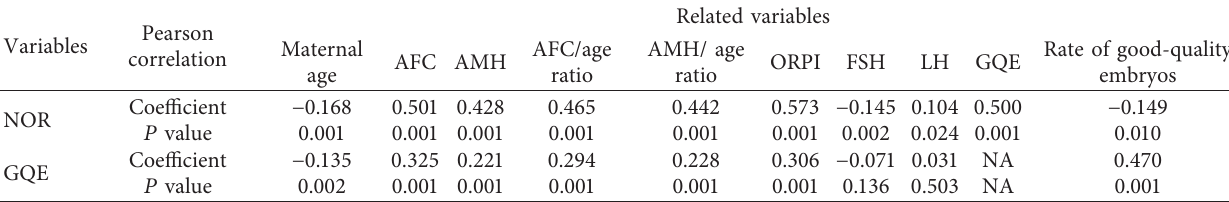
Table 2: Pearson correlation analysis of all variables in relation to NOR and